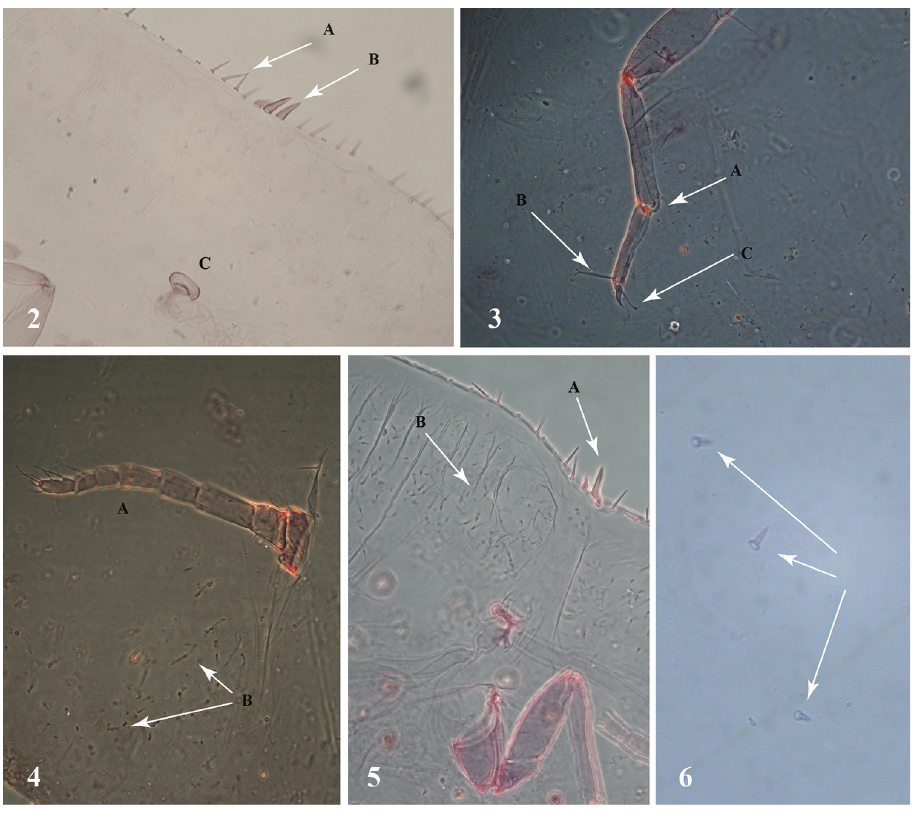
Figures 2–6. Pulvinaria tenuivalvata (Newstead). 2A marginal setae 2B anterior spiracular setae 2C anterior spiracle 3A tibio-tarsal articulatory sclerosis 3B tarsal digitules 3 , claw digitules unequal 4A antenna 4B ven- tral tubular ducts of the type I 5A posterior spiracular setae 5B ventral tubular ducts of the type I 6 dorsal conical